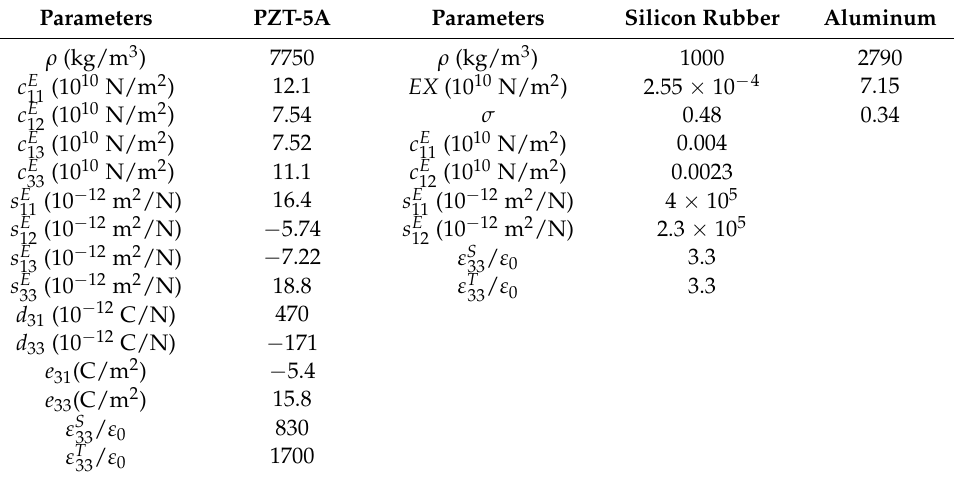
Table 1. Material